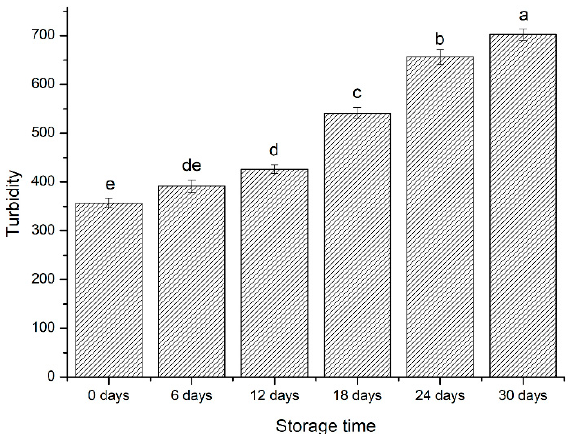
Figure 1. Turbidity of SPI (mmol ∙ mg − 1 ) with different storage times. Different letters (a, b, c, d, e) indicate significant differences ( p < 0.05).